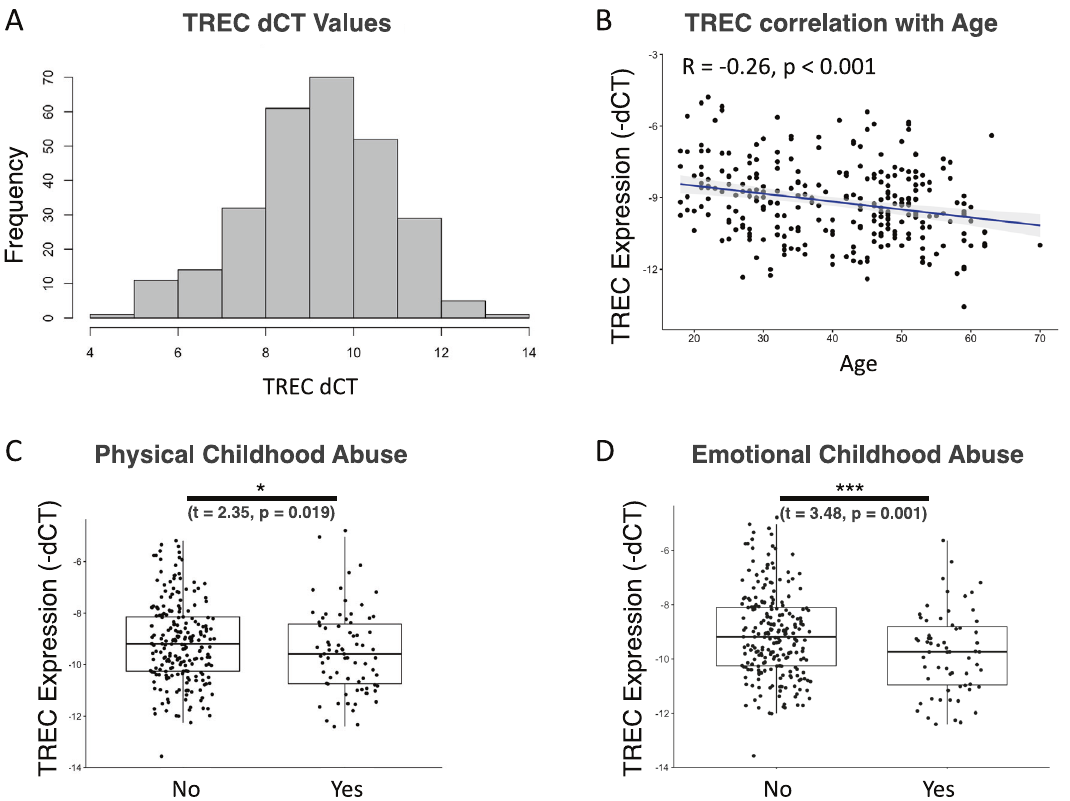
Fig. 2 Associations between TREC levels and age and childhood trauma in humans (men and women). Note that TREC data are depicted as -dCT to clarify that higher dCT integer values indicate lower levels of TRECs. A TREC dCT values were normally distributed. B TREC levels were negatively correlated with age, and lower in subjects that experienced C childhood physical abuse or D childhood emotional abuse; for details, refer to Table 2. * p < 0.05, ** p < 0.01, ** *p < 0.001, N = 297.